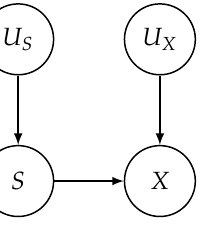
Figure 2. Causal Graph satisfying